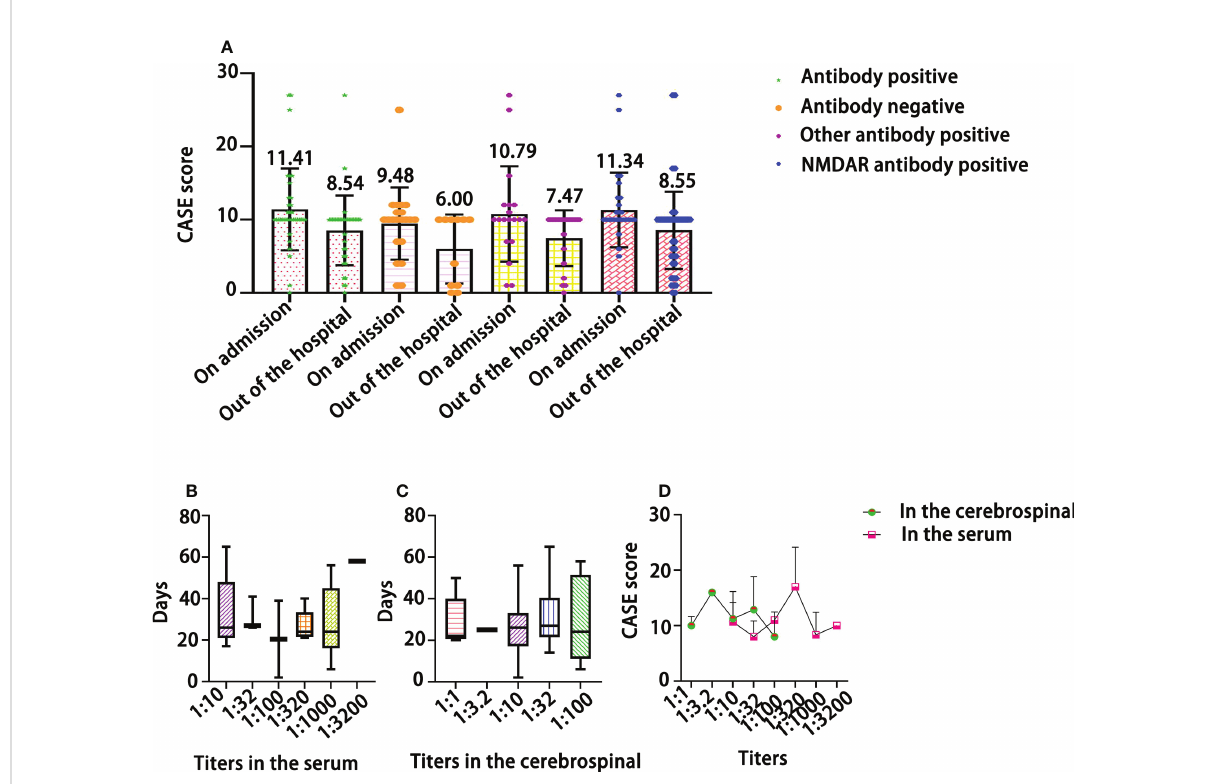
FIGURE 4 The relationship of CASE total scores with the results of antibody assays (A) , the length (days) of hospitalization by antibody titer in the serum (B) and in the cerebrospinal (C) , and the distribution of CASE scores by NMDAR antibody titer (D)